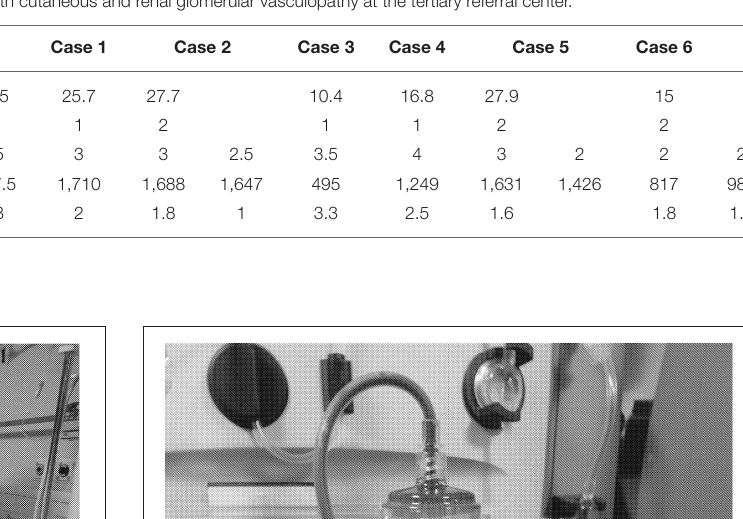
TABLE 3 | Summary of the plasma exchange therapy in six dogs with cutaneous and renal glomerular vasculopathy at the tertiary referral center. Median IQR Q1 Q3 Case 1